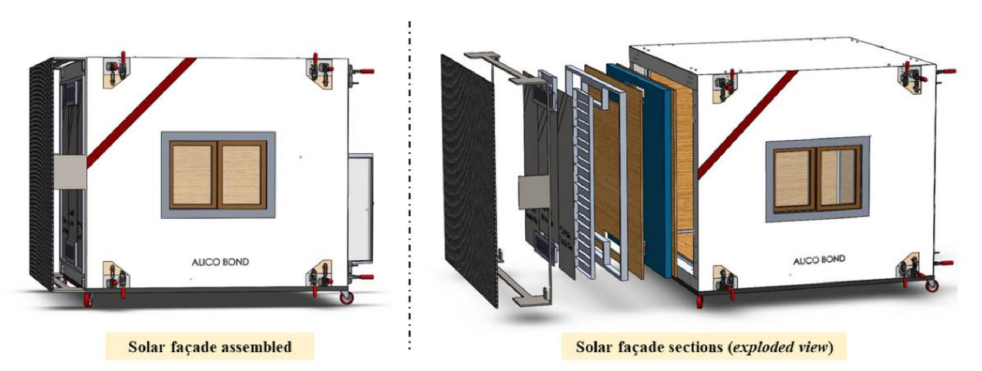
Figure 26. Solar façade sections mounted on the side wall of ThermoGreen ®